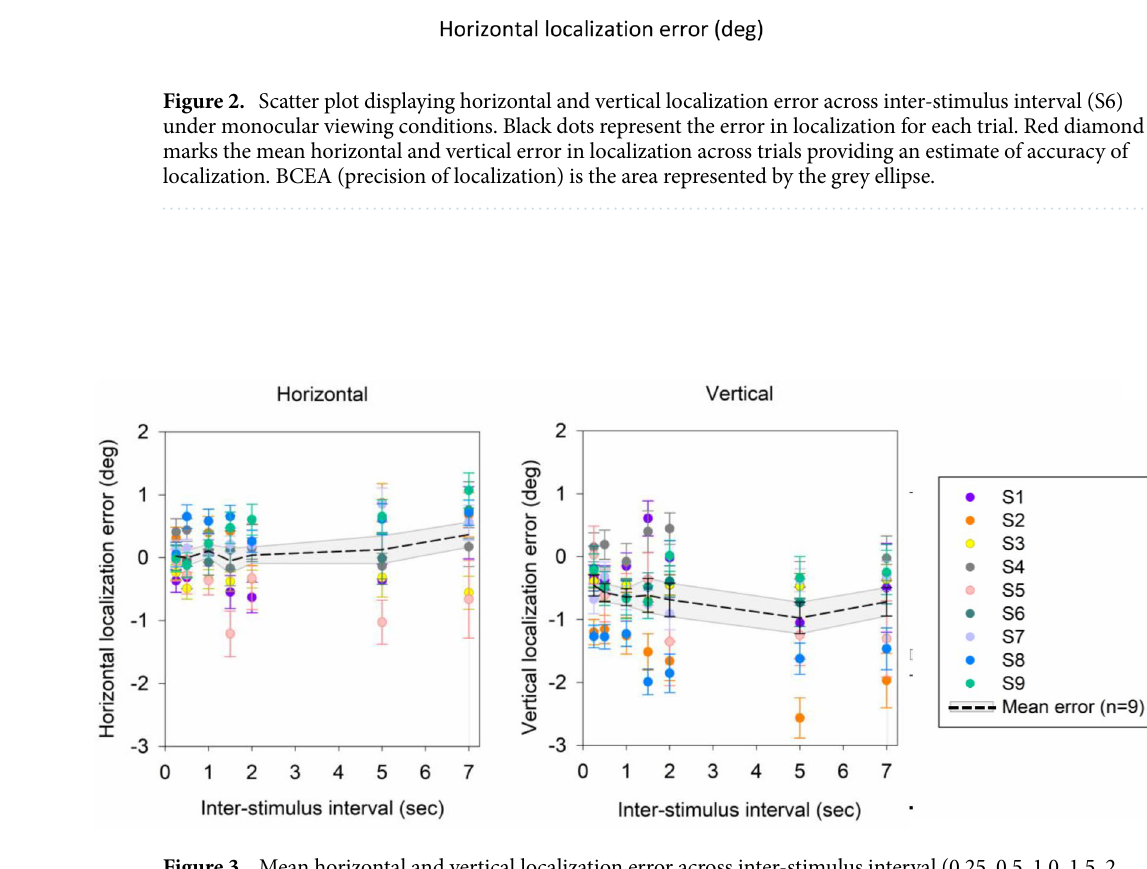
Figure 3. Mean horizontal and vertical localization error across inter-stimulus interval (0.25, 0.5, 1.0, 1.5, 2, 5 and 7 s). Black dashed line represents the mean localization error and grey shading represents the standard error of localization for all subjects (n = 9). Each color represents the mean and standard error of horizontal and vertical error in localization for each